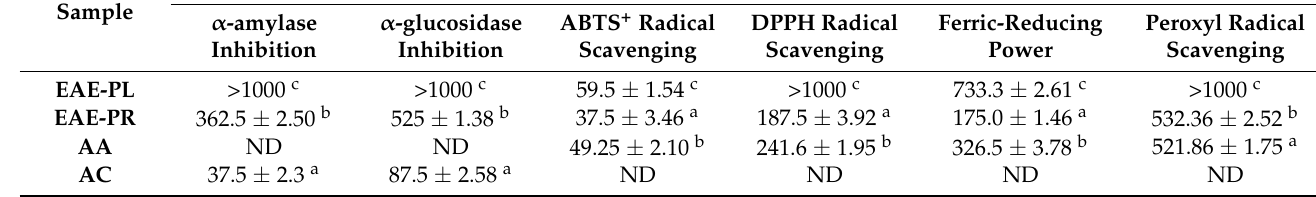
Table 2. Antioxidant activities and diabetes-related enzyme inhibitory activities of the EAE-PL and EAE-PR compared to ascorbic acid (AA) and acarbose (AC), respectively. ND, not determined. The superscripts represent significance ( p < 0.05) among